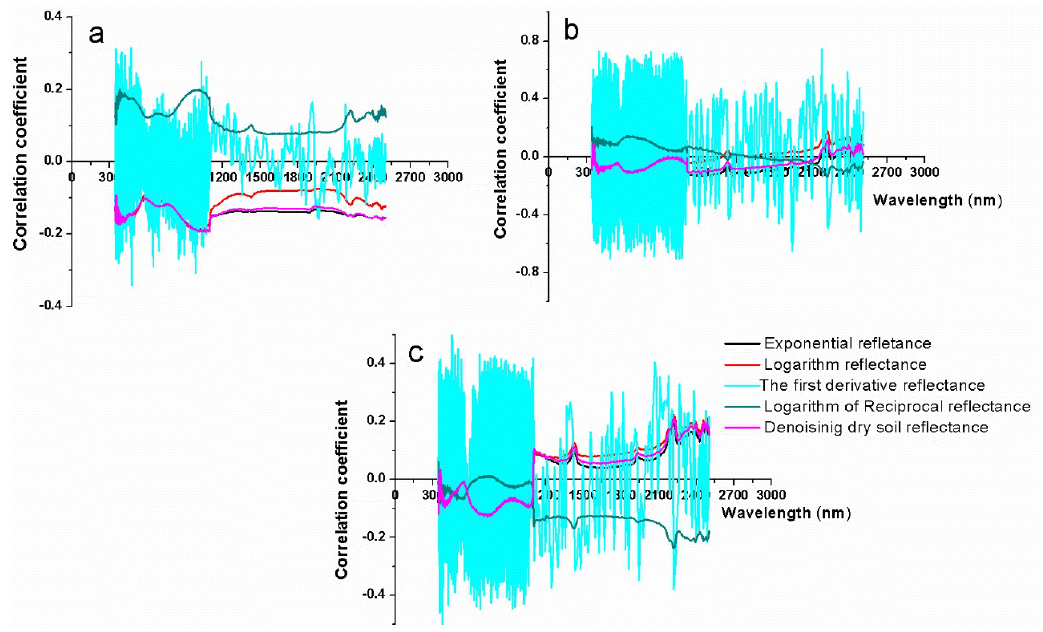
Figure 5. Pearson correlation coefficients between the soil heavy metal content and spectral indices for ( a ) As; ( b ) Cd; and ( c ) Hg (p = 0.01).